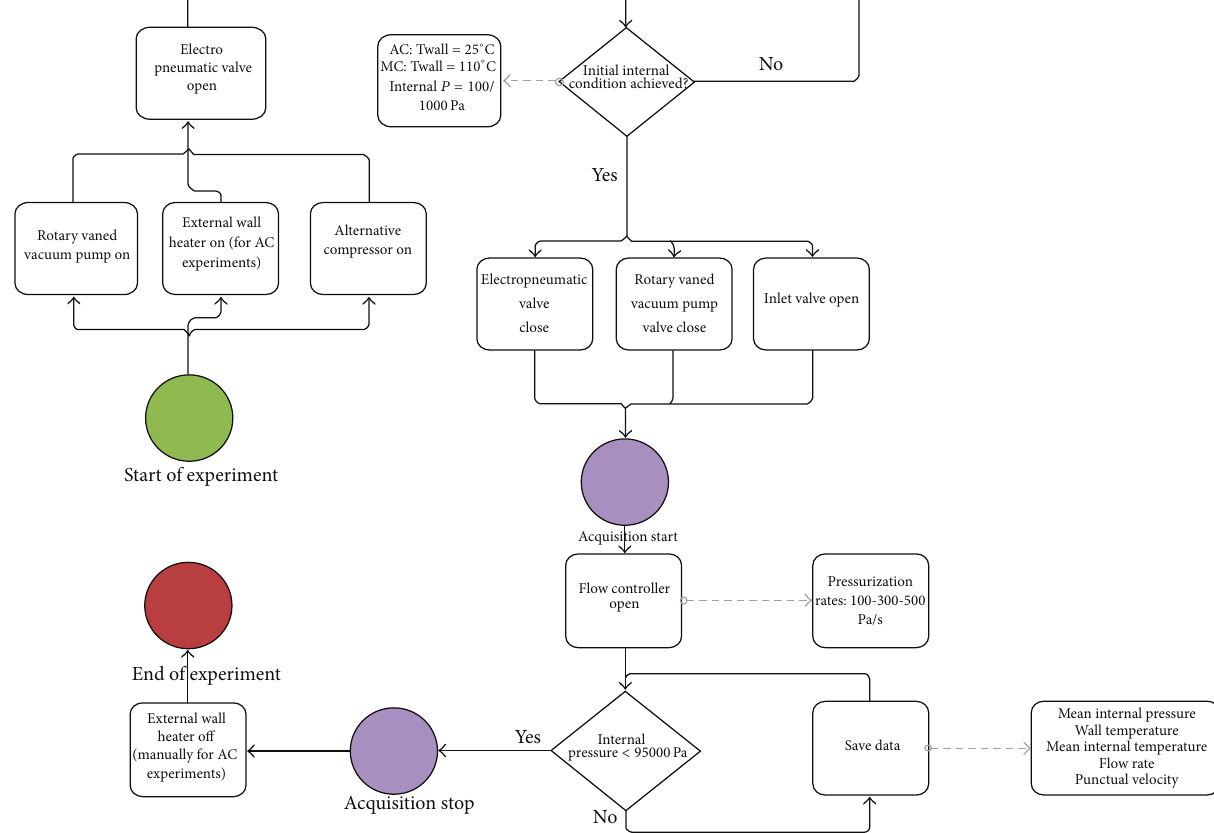
Figure 13: LOVA flowchart experimental